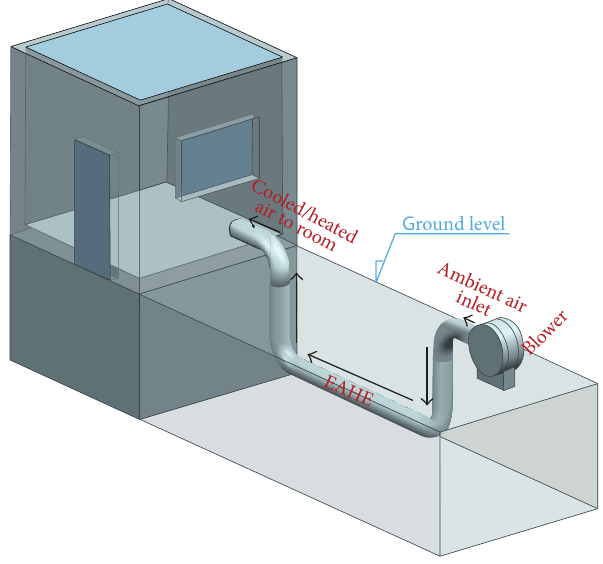
Figure 1: Open loop earth-air heat exchanger.